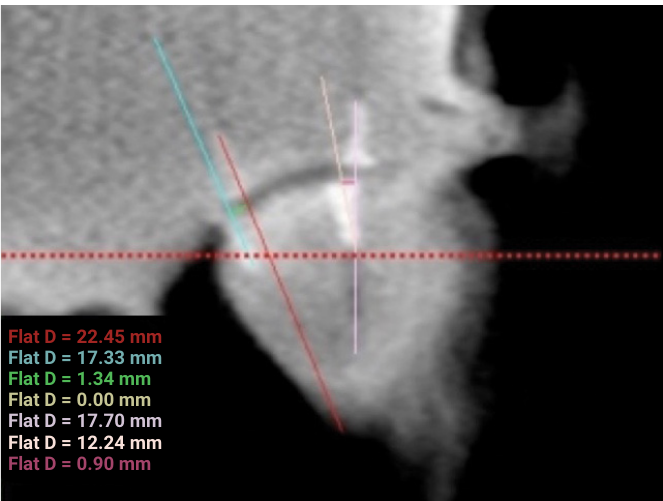
Figure 4. Measuring the changes between the distances of the metallic markers (screws) on the coronal reformatting. Lines (blue, red, pink and light pink) representing the long axis of the screws were done using the DISTANCE tool of the software at the level of the screw head of the condyle, perpendicular to the lines previously marked, representing the long axes of the screws, and the distance between the lines were measured. In this picture, the distances between the lines of the long axes of the screws of the glenoid fossa and condyle were 1.34 mm and 0.90 mm (green and purple lines).